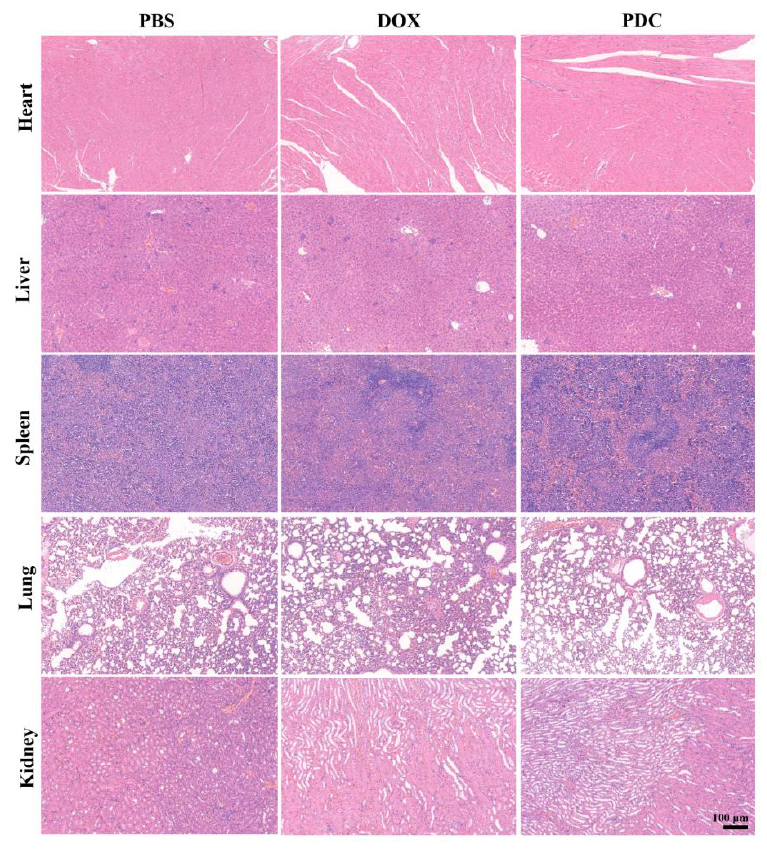
Figure 6. H&E staining of the major organs harvested from the mice of different treatment groups. Scale bar, 100 μm.